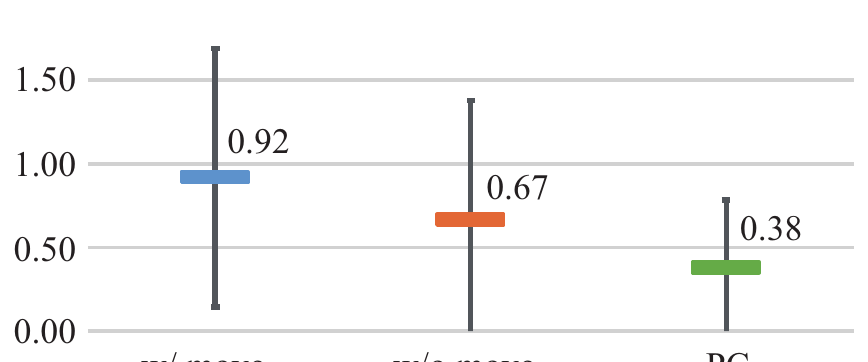
Figure 18. LF/HF data (P-D).